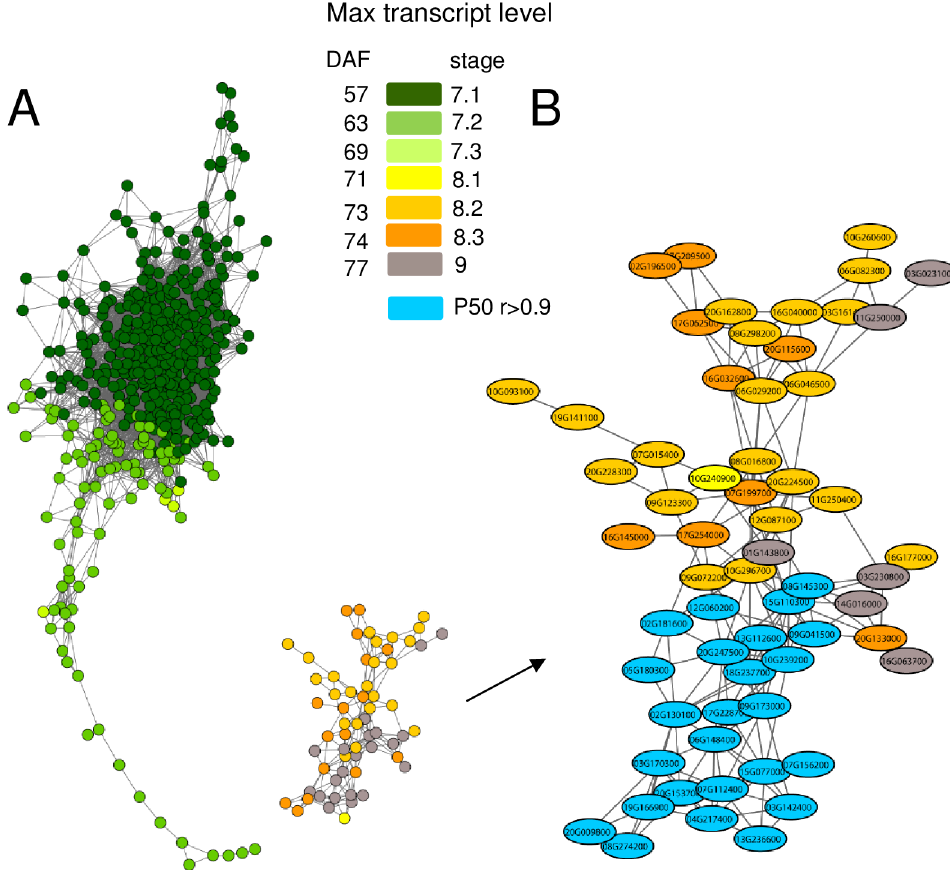
Fig 6. Transcription factor co-expression network of soybean seed maturation. (A) Gene co-expression network of seed maturation visualizedusing an organiclayout in Cytoscape. Temporal analysisof nodesin the network was obtainedby coloringeach gene by its specific expressionprofile duringseed development. Dark- green; high transcript levels at seed filling (stage7.1); green, light-greenand yellow, transitory transcript levels maximum at stage 7.2, 7.3 and 8.1 respectively;light-orange,dark-orange and grey, transcript levels increasing during late seed development, being maximum at stage 8.2, 8.3 and stage 9. (B) Zoom on the gene module correspondingto late maturation. Nodes correlating with longevity(PCC > 0.9) are colored in blue. Text labels indicate gene numbers.